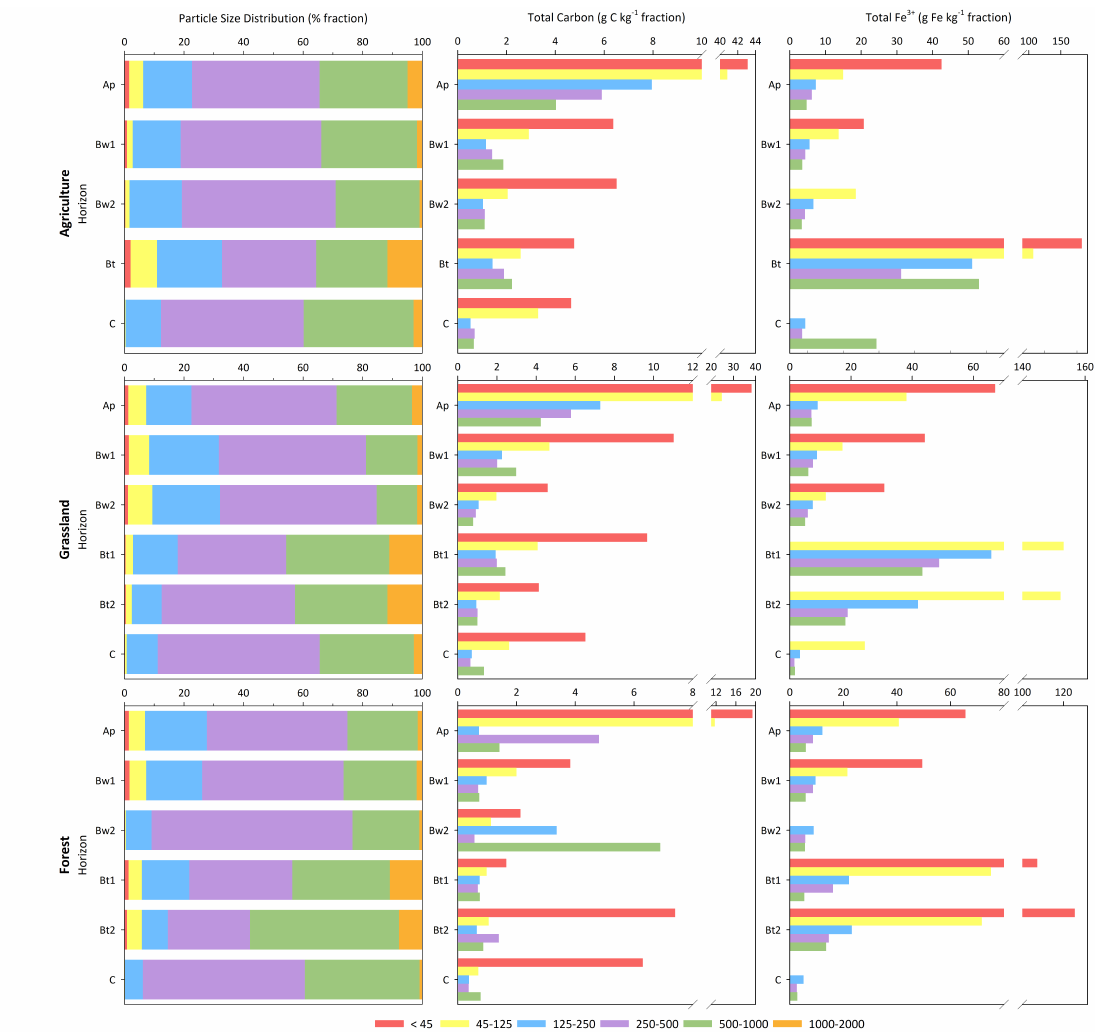
Figure2. Particlesizedistribution, totalcarbon, andtotaliron(Fe 3 + ; CDBextractable)forsixparticle-size fractions ( µ m) in three sandy Alfisols under di ff erent land use. Note di ff erent x-axis scales. Due to low amounts of < 45 µ m soil samples, total iron was not analyzed for all